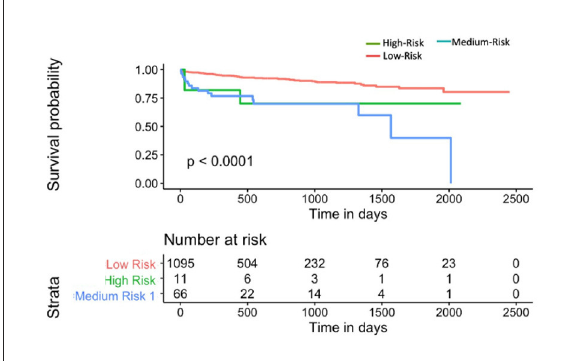
FIGURE9 Kaplan-Meier plot for MACE-free survival according to M nom risk groups for S v (4) [C-index 0.6 (se = 0.023]). HR between high and low risk: 3.24